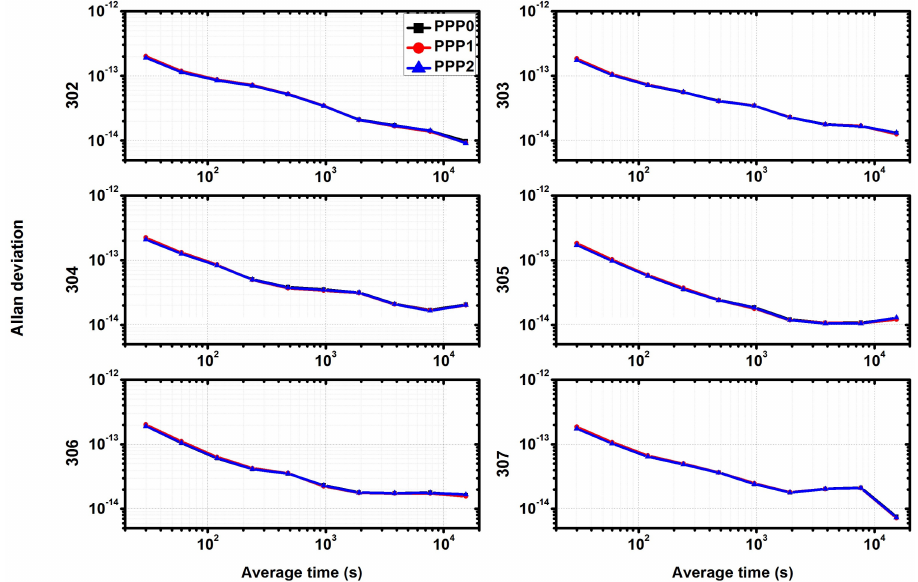
Figure 13. Comparison of Allan deviation between different models by stations CEDU ( left side) and KAT1 ( right